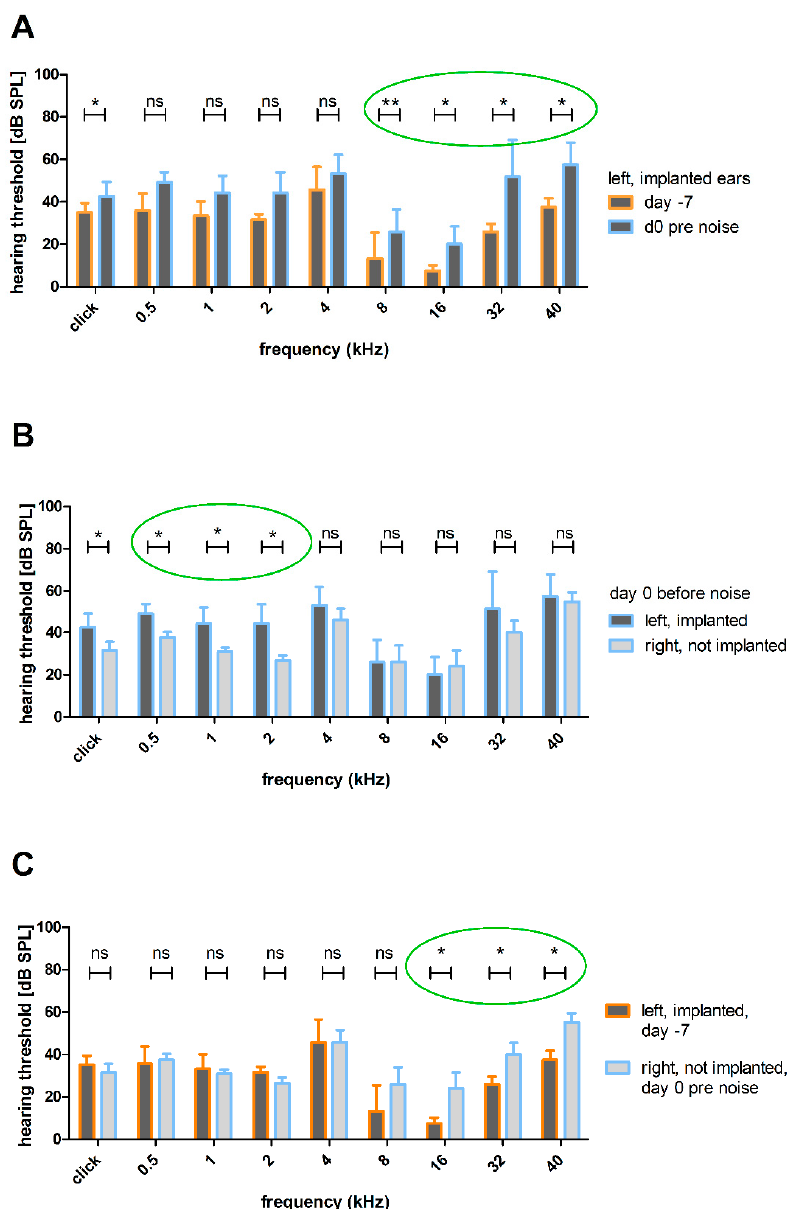
Figure 8. Effect of the HDD implantation on ABR thresholds. ( A ) Mean click and frequency-specific hearing thresholds of the left (implanted) ears before noise trauma compared to naïve condition. The implantation increased the threshold significantly in frequencies above 8 kHz (green circle) and also in the click condition. ( B ) Mean click and frequency-specific hearing thresholds of left (implanted) ears compared to right (not implanted) ones on day 0 before noise trauma. In contrast to the previously reported impact of the implantation (A), there is only a significant difference between left (implanted) and right (not implanted) ears in frequencies below 4 kHz (green circle) and in the click condition. ( C ) Mean click and frequency-specific hearing thresholds of left (implanted) ears on day − 7 and right (not implanted) ears on day 0 before noise. There is a significant difference in frequencies above 16 kHz (green circle). ns = not significant; * p ≤ 0.05; ** p ≤